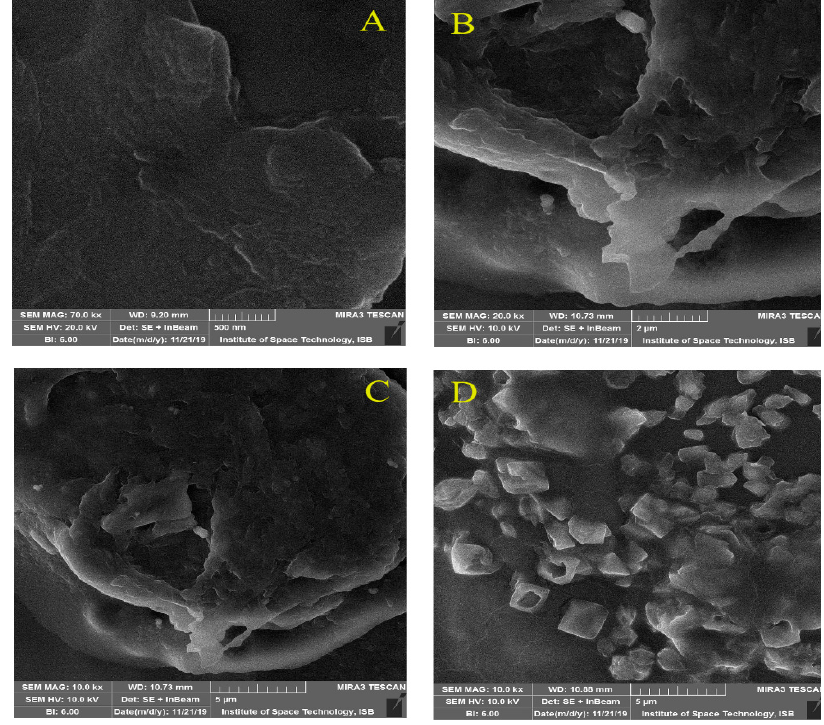
Figure 3. SEM of ( A , B ) S50P50 ( C , D ) S50P50D15(3). Bar scales are